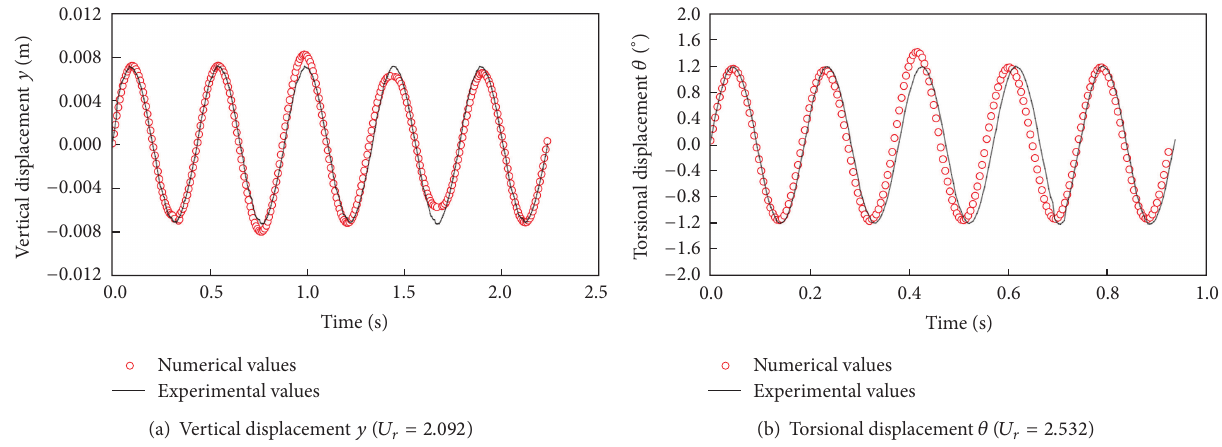
Figure 9: Comparisons of vertical and torsional displacements obtained from Hybrid-LES and wind tunnel